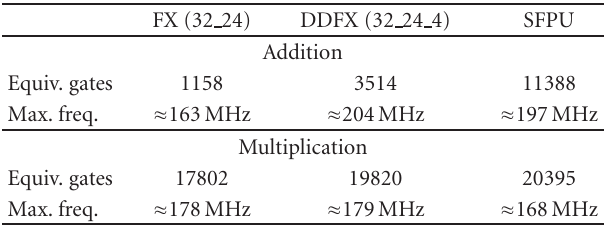
Table 3: Implementation results for Virtex II Pro (XC2VP30) using ISE 9.2.4i with default